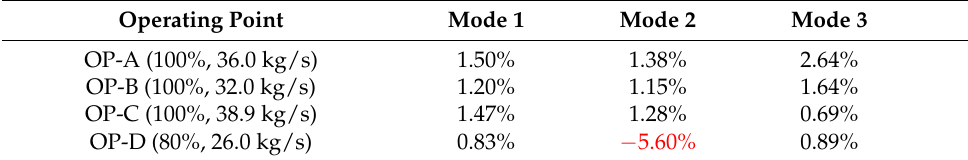
Figure 16. Aerodynamic damping as a function of nodal diameter: ( left ) OP-C; ( right ) OP-D. Table 5. Minimum of aerodynamic damping. Unstable condition marked in